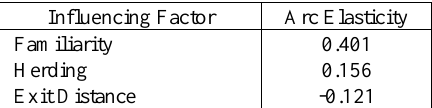
Table 5. Arc elasticity scenario 1